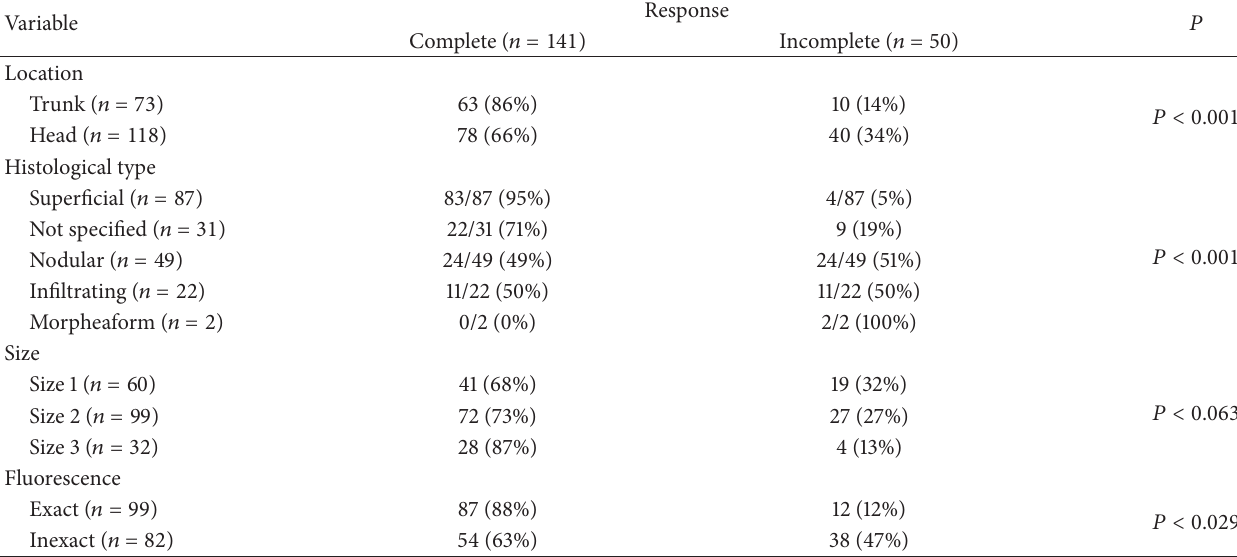
Table 2: Response according to the measured variables: location, histological type, size, and fluorescence.